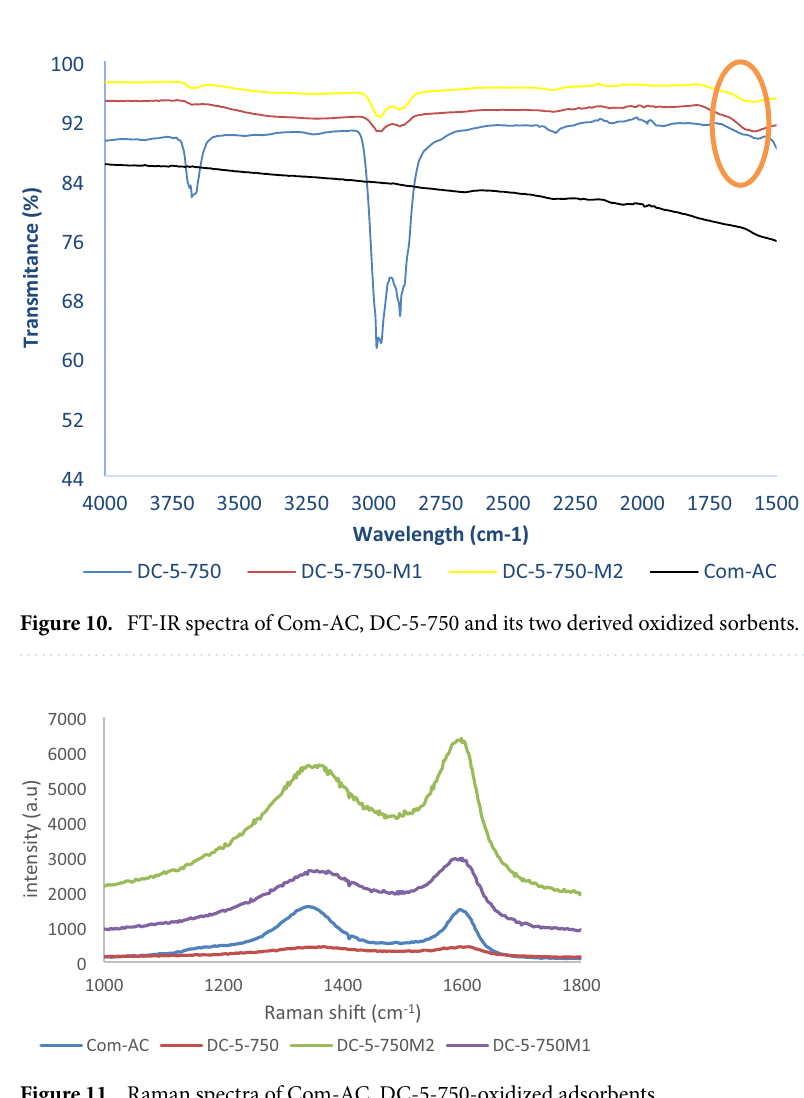
Figure 11. Raman spectra of Com-AC, DC-5-750-oxidized adsorbents.